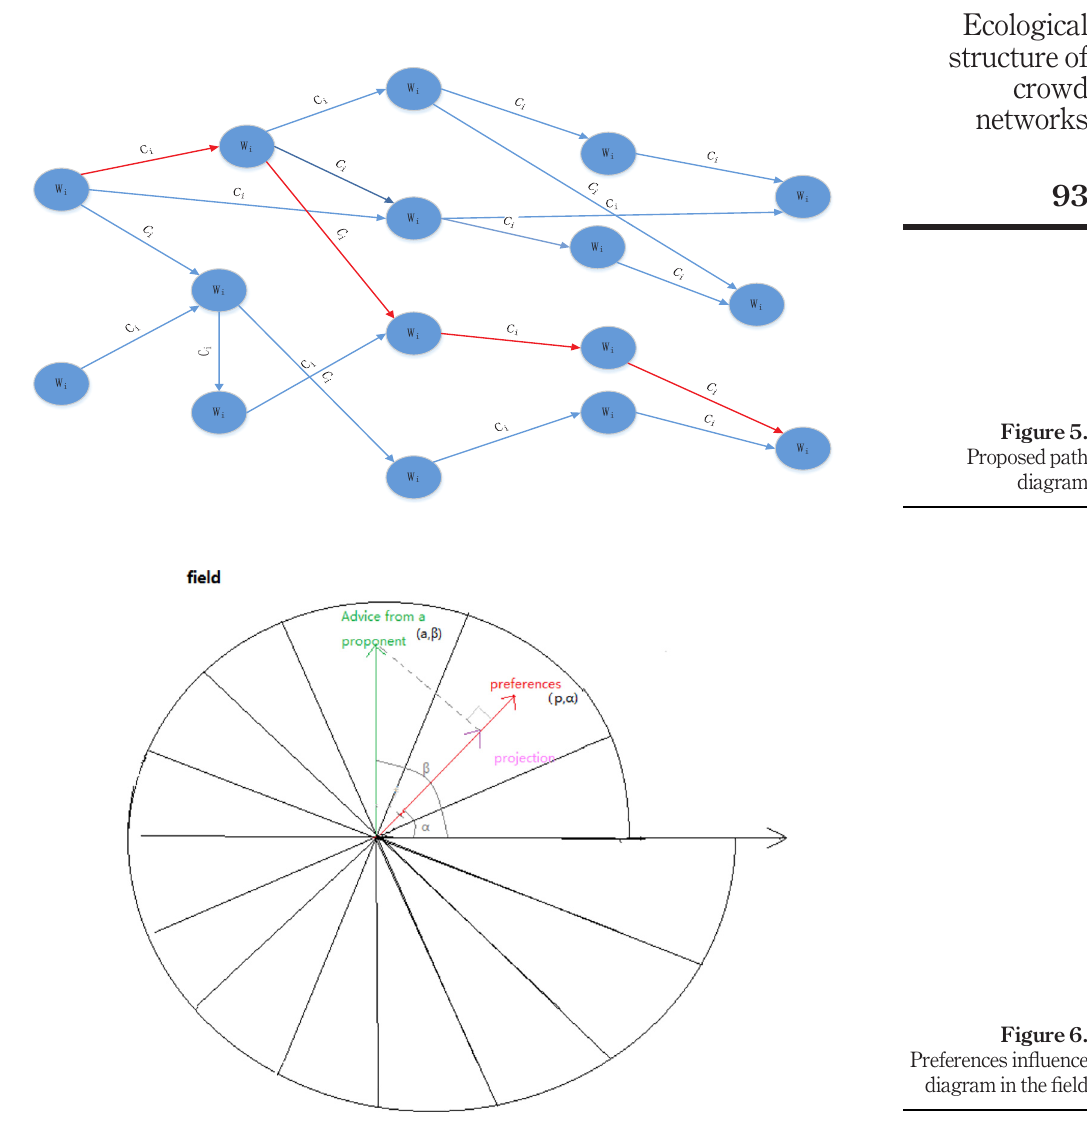
Figure 6. Preferences in fl uence diagram in the fi eld